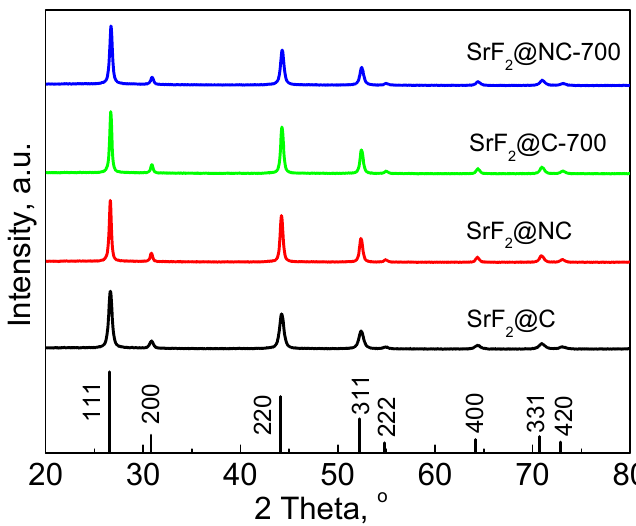
7 of 14 Figure 7. TEM images of ( a ) SrF 2 @C, ( b ) SrF 2 @NC, ( c ) SrF 2 @C-700, and ( d ) SrF 2 @NC-700. The catalysts were further examined by TEM (Figure 7). As highlighted by the inset of Figure 7a,d, SrF 2 particles are clearly embedded in the carbon structure, and the particles are separated from each other by the carbon structure. Even with calcination at 700 °C, ultrafine particles are retained. The selected area electron diffraction (SAED) reinforces that the SrF 2 particles are highly crystalized (white spot). However, the SAED does not form a completed diffraction ring, which is a structure in which the particles are separated by carbon-containing compounds [29,30]. Consistent with XRD patterns, the most developed (111) facet is observed in the high-resolution TEM images with the